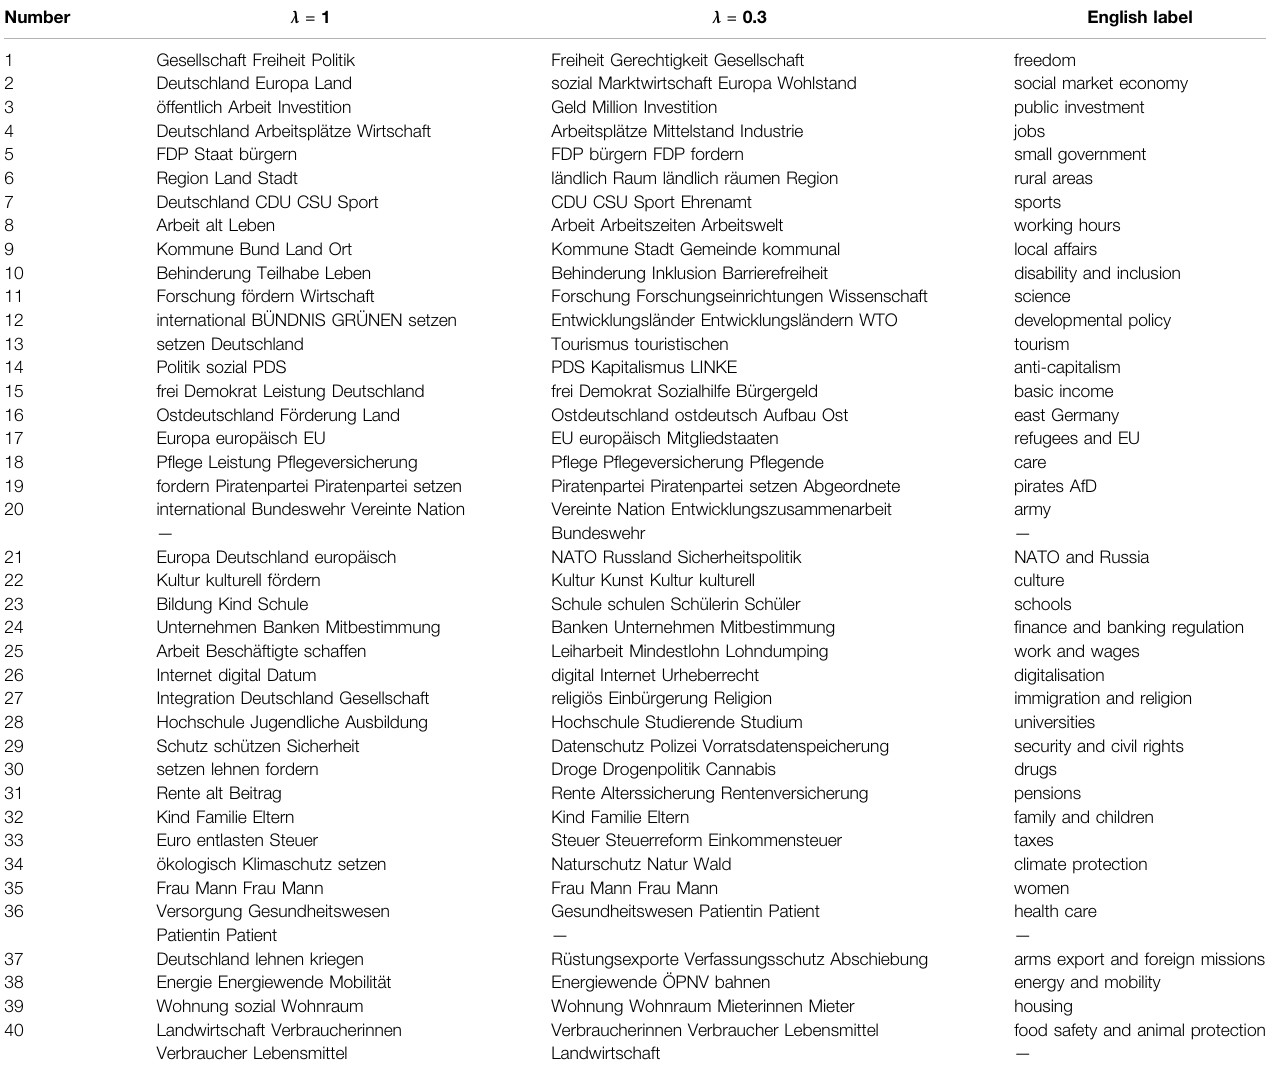
TABLE 3 | Topics of topic model B trained on German manifestos from 1989 to 2017.